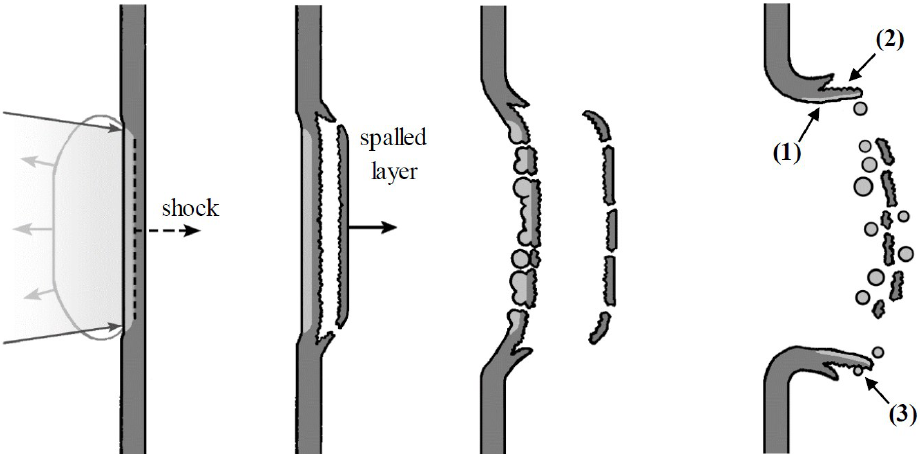
Figure 13. Schematic interpretation of partial melting, subsequent spall fracture and debris ejection in laser shock-loaded Fe. Pale grey represents molten metal. Numbers in the last picture refer to Figure